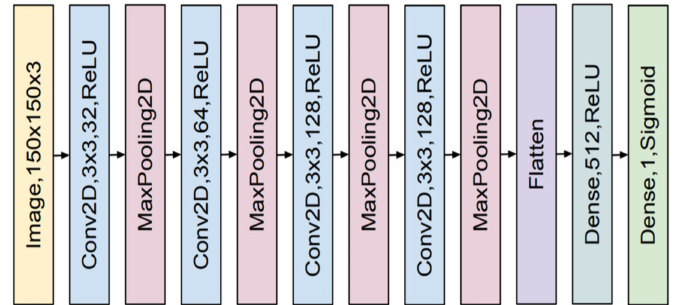
Figure 3. Example of the convolutional neural network (CNN) structure for processing the RGB image of 150 × 150 pixels in size. The CNN model consists of four convolutional layers with various number of the 3 × 3 kernel and the ReLU activation function (blue rectangles) with each followed by a pooling layer (red rectangles) and two fully-connected (dense) layers (green rectangles) after a flattened